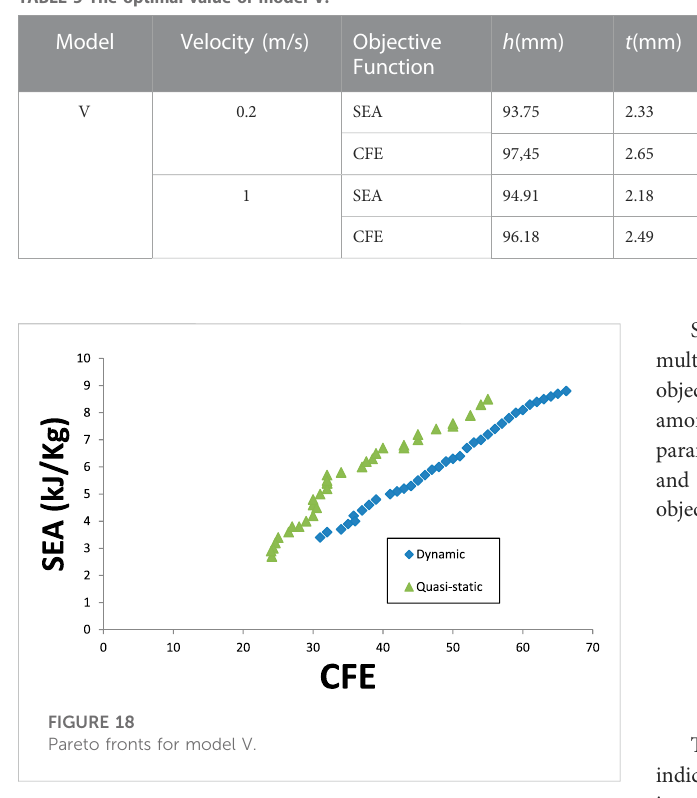
TABLE 5 The optimal value of model V.